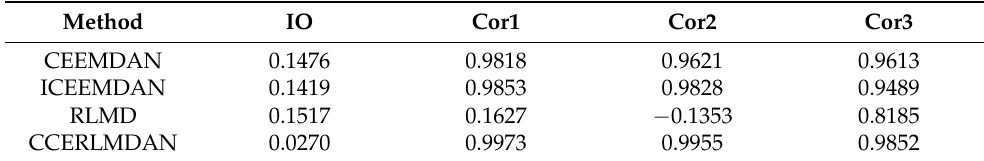
Table 2. The orthogonality and correlation coefficient of the four methods.